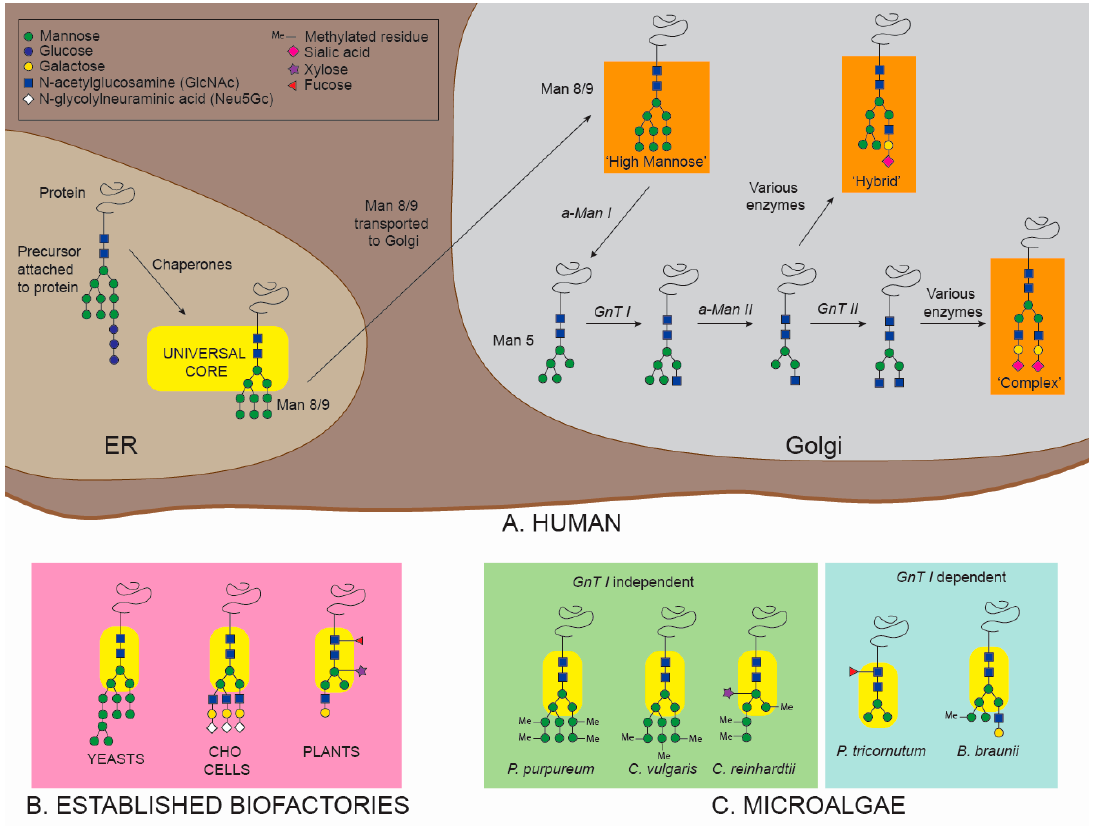
Figure 1. A schematic of N -glycosylation patterns found in ( A ) humans, ( B ) established biofactories including yeasts, plants, CHO cells, and ( C ) specific N -glycosylation patterns in microalgae. Glycans shown for ( A ) humans and ( B ) established biofactories are only illustrative and do not represent the totality of possible glycoforms obtained from these organisms. Di ff erences in specificity of yeast, CHO, plant, and microalgal Golgi glycosyltransferases and glycosidases lead to variations in the final glycosylation profiles compared to humans. Consequently, glycans N -linked to recombinant proteins produced in these biofactories di ff er from native human proteins, necessitating glycan engineering to produce e ffi cient and safe biopharmaceuticals in these alternative host systems. Green circle = Mannose. Blue circle = Glucose. Yellow circle = Galactose. Blue square = GlcNAc. White diamond = Neu5Gc. Me = Methylated residue. Fuchsia diamond = Sialic acid. Purple star = Xylose. Red triangle = Fucose. α -Man I = α -mannosidase I. GnT I = N -acetylglucosaminyltransferase I. α -Man II = α -mannosidase II. GnT II = N -acetylglucosaminyltransferase